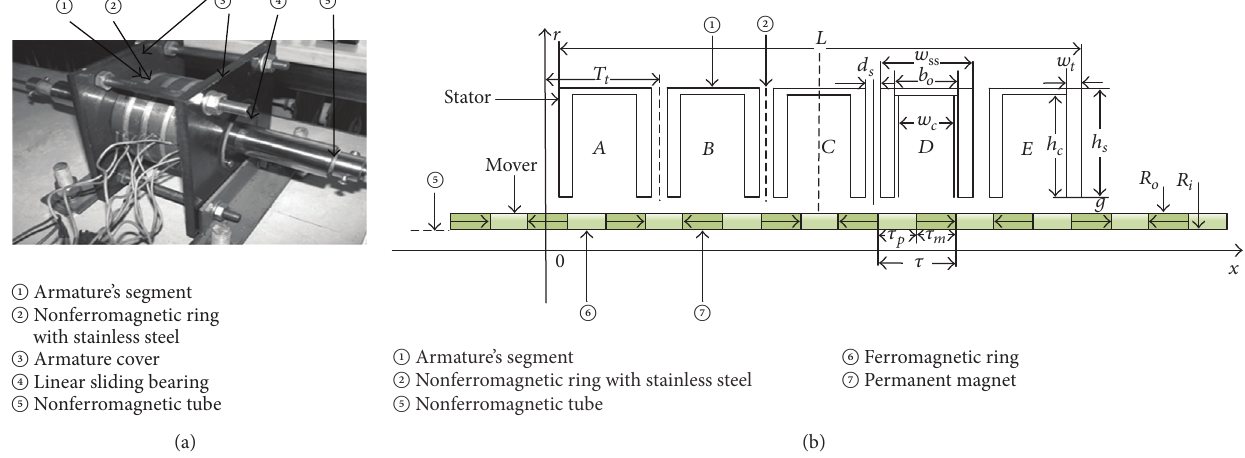
Figure 1: Physical structure of PMTLM and the schematic outline of the halved motor cross section: (a) motor physical; (b) cross section of the motor.